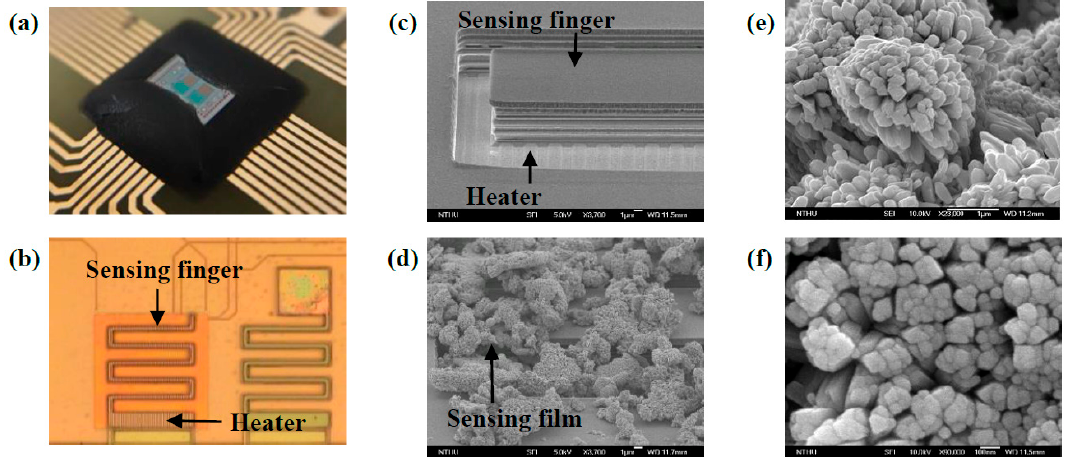
Figure 3. ( a , b ) OM micrographs of the sensing chip, ( c , d ) SEM of the sensing finger before/after ZnO- SnO 2 dispensing, and ( e , f ) SEM of the ZnO-SnO 2 thin film.